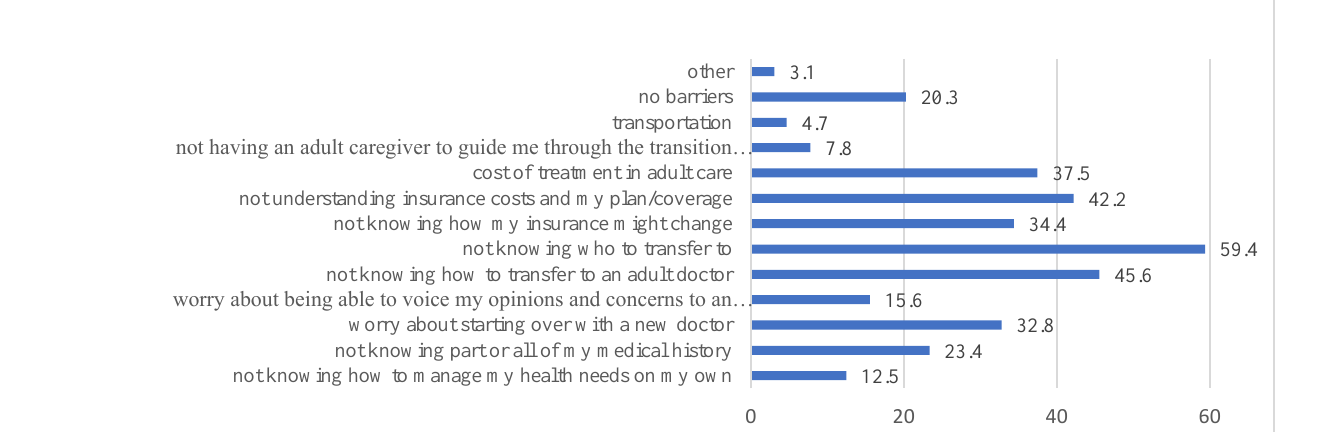
Figure 2. Summary of the transition and transfer barriers endorsed. Note: the x -axis corresponds to the number of patients (%).